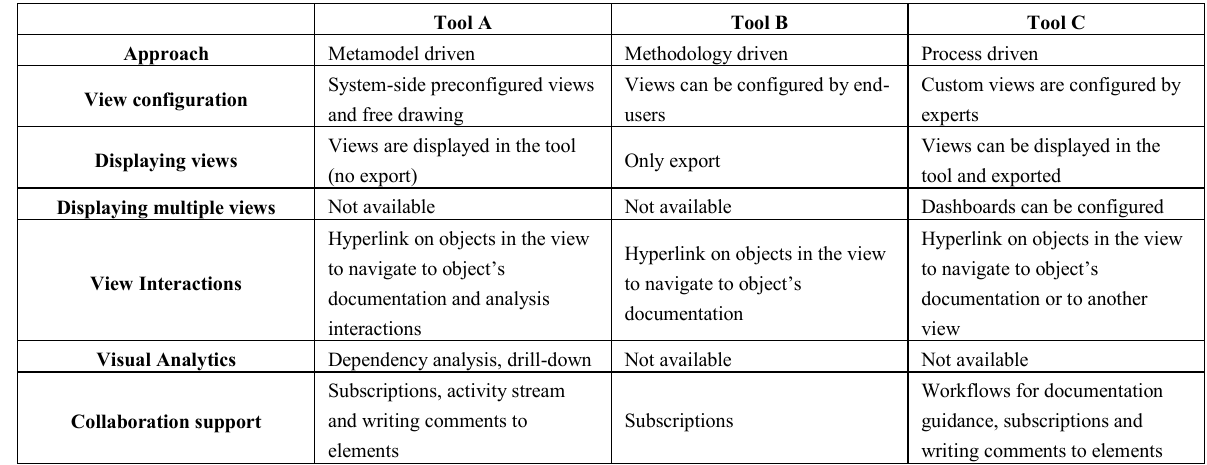
Table 2. Comparison of tools we